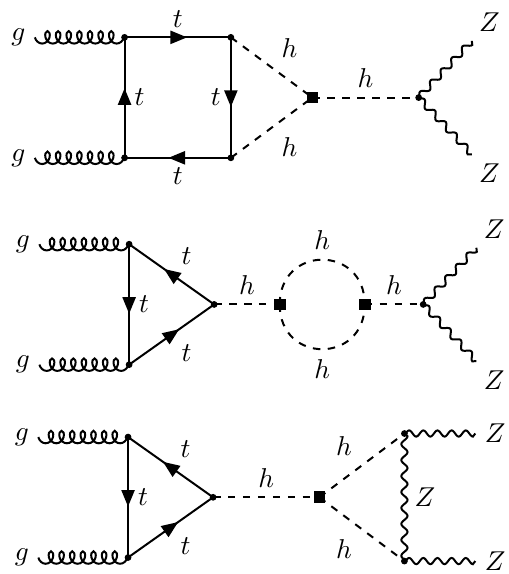
Figure 1. Representative Feynman diagrams that lead to a O ( λ ) correction to the process gg → h ∗ → ZZ . The black boxes denote insertions of the operator O 6 introduced in (2.1). Consult the main text for further